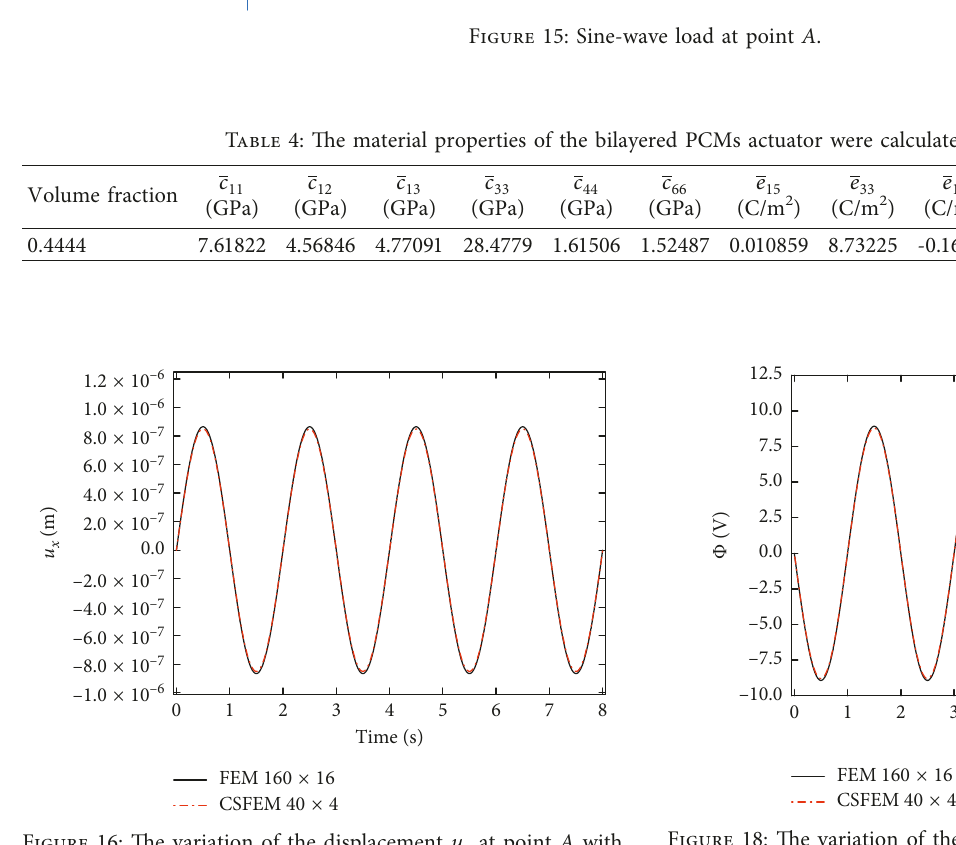
Figure 16: The variation of the displacement u respect to time.